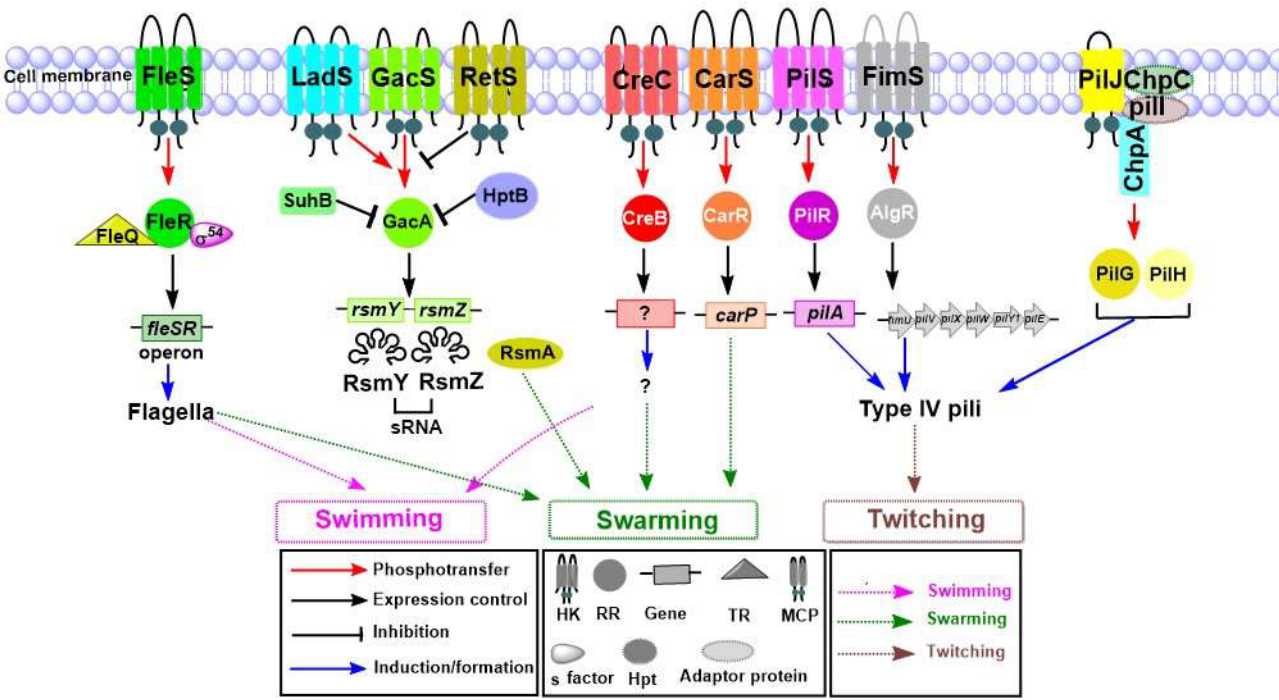
Figure 4. Functional characterization of TCSs in P. aeruginosa and their involvement in motility-related virulence. The FleS sensor HK phosphorylates its cognate RR FleR and facilitates transcription of flagellar genes. The interconnected tran- scriptional regulatory circuits consisting of FleR, FleQ TR, and σ 54 factors have a major role in flagellar biogenesis and are responsible for swimming and swarming motility. GacSA works along with hybrid sensor HKs LadS and RetS through a parallel and antagonistic mechanism. The free RsmA regulatory protein is involved in swarming motility. The SuhB reg- ulator indirectly regulates motility through the GacSA, HptB also works along with GacSA and indirectly controls free RsmA. CreCB plays a major role in swarming motility by an unknown mechanism. CarSR is involved in swarming motility through its target carP . PilSR has a major role in controlling type IV pili and twitching motility. FimS-AlgR also is im- portant for twitching motility. The Chp chemosensory system impacts type IV pili. The MCP receptor PilJ senses the en- vironmental signal and phosphorylates ChpA using two adaptor proteins, ChpC and PilI. Phosphorylated PilG and PilH play a role in the extension and retraction of type IV pili. 4.2.2. Role of TCSs in Twitching Motility P. aeruginosa uses hair-like appendages, known as type IV pili, which are an essential virulence factor [114]. Pili are surface organelles important for biofilm initiation, coloni- zation, bacterial aggregation, twitching, and cellular invasion. Most type IV pili use cyto- plasmic ATPase to elongate and retract, which are important features of motility [114]. Various TCSs are responsible for production, function, and control of type IV pili in P. aeruginosa . Previous research has shown the diversity of a type IV pilin allele based on P. aeruginosa strains collected from CF patients and the environment [115]. One report showed that more than 40 P. aeruginosa genes contribute to the function of type IV pili [66]. These genes encode major structural protein PilA and other minor proteins such as PilE, PilV, PilX, PilW, PilY1, PilY2, and FimT, which are responsible for formation of the tip and base of the pili [62]. Additionally, other proteins regulate the production of pili and are responsible for twitching motility in response to environmental signals, as shown in Figure 4. PilSR is the most important TCS responsible for expression of the gene pilA [63]. The role of FimS-AlgR in the regulation of twitching motility has been explained in earlier studies [65,66]. FimS-AlgR controls the twitching motility by positively regulating the expression of the genes involved in the assembly of minor pilins FimU-PilVWXE and the putative adhesin PilY1 prime pilin, which are known to mediate the twitching motility in P. aeruginosa [64]. The twitching motility of P. aeruginosa is controlled by a chemosen- sory system, Chp system [67]. The putative HK ChpA is coupled with a methyl-accepting